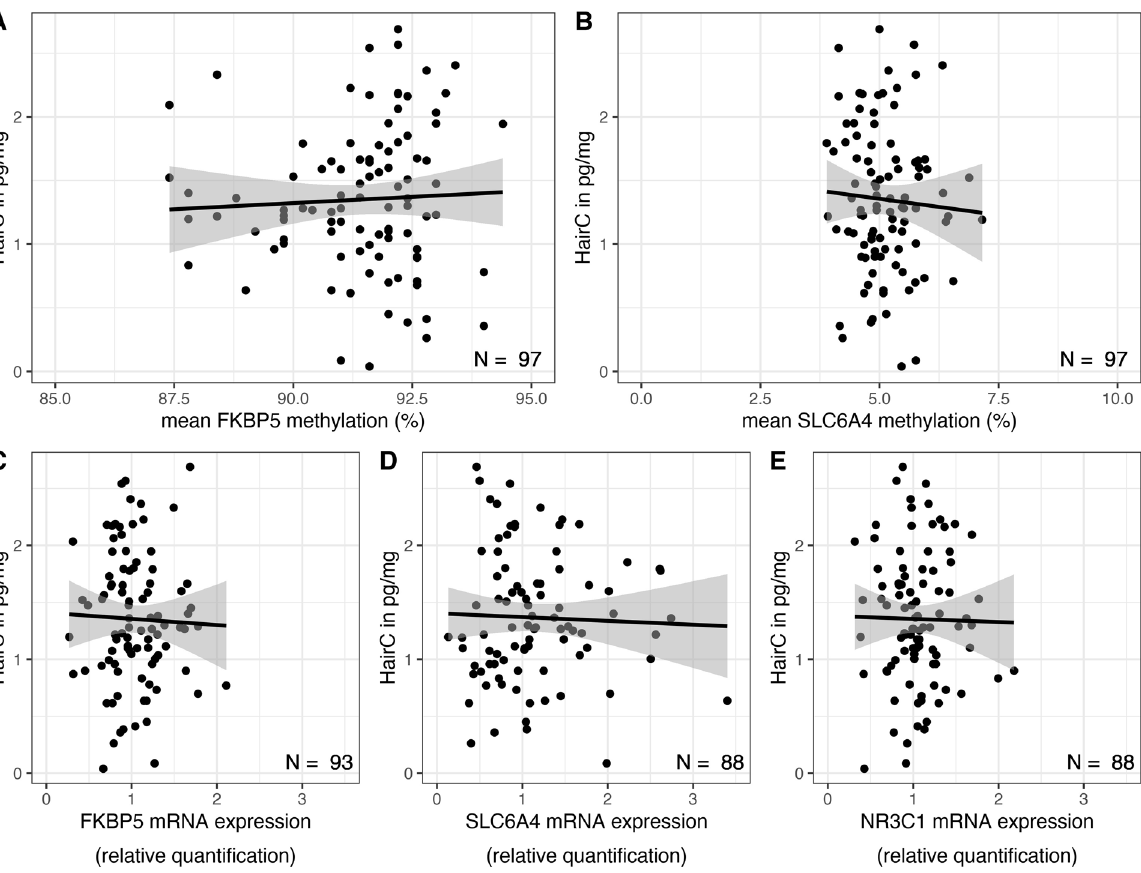
Fig. 3 Association of DNA methylation and mRNA expression with hairC. Upper part: Mean DNA methylation levels were not signi fi cantly related to hair cortisol concentration (hairC). A Mean DNA methylation of FKBP5 . B Mean DNA methylation of SLC6A4 . Lower part: mRNA expression levels were not signi fi cantly related to hairC. C mRNA expression of FKBP5 . D mRNA expression of SLC6A4 . E mRNA expression of NR3C1